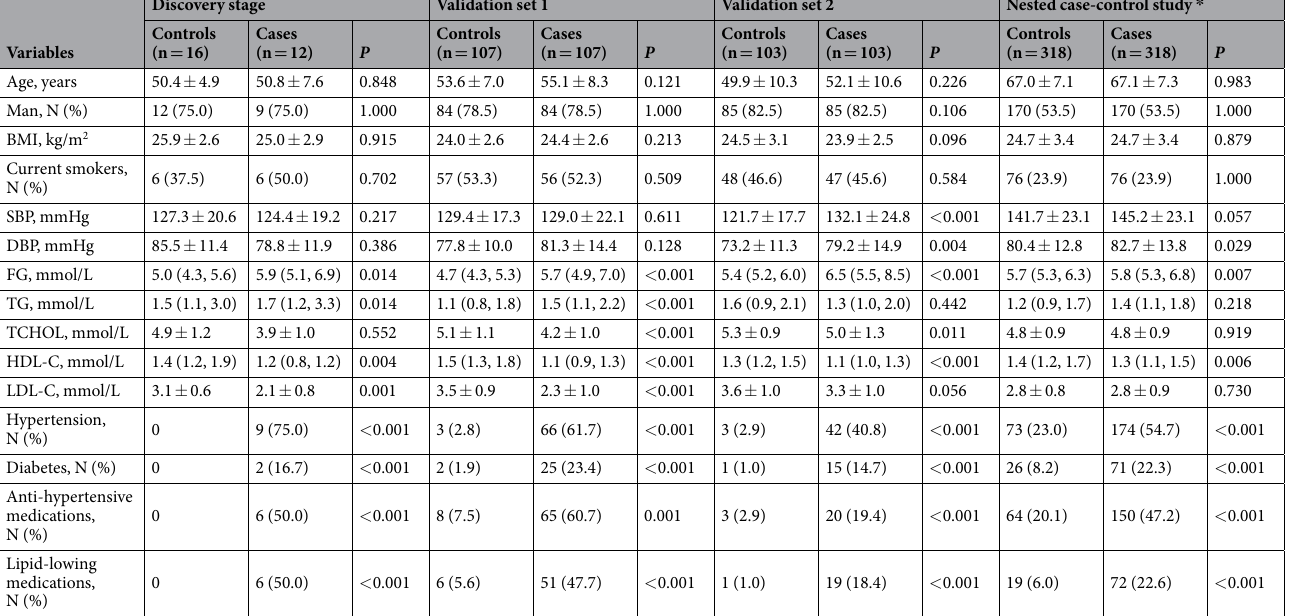
Table 1. Demographic and Clinical Characteristics of the Study Populations. Continuous variables are presented as mean ± SD or median (25th, 75th), and the distribution differences between cases and controls were tested using ANOVA or Mann-Whitney U test. Categorical variables are presented as N (%), and the proportion differences between cases and controls were tested using Chi-square test. BMI, body mass index; SBP, systolic blood pressure; DBP, diastolic blood pressure; FG, fasting glucose; TCHOL, total serum cholesterol; TG, triglycerides; HDL-C, high-density lipoprotein cholesterol; LDL-C, low-density lipoprotein cholesterol. * Demographic and clinical characteristics recorded at the 2013 baseline of the